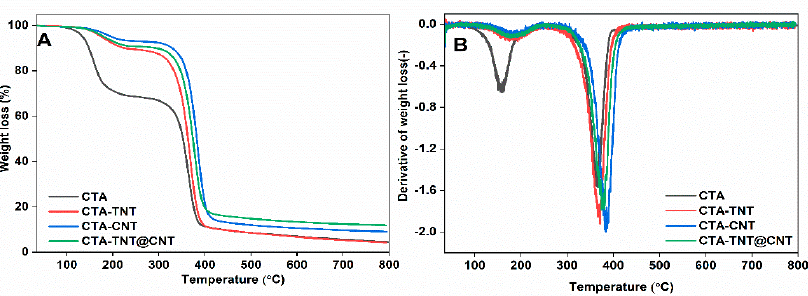
Figure 4. ( A ) TGA and ( B ) corresponding DTG analysis curves of pristine membranes and MMMs in the study.